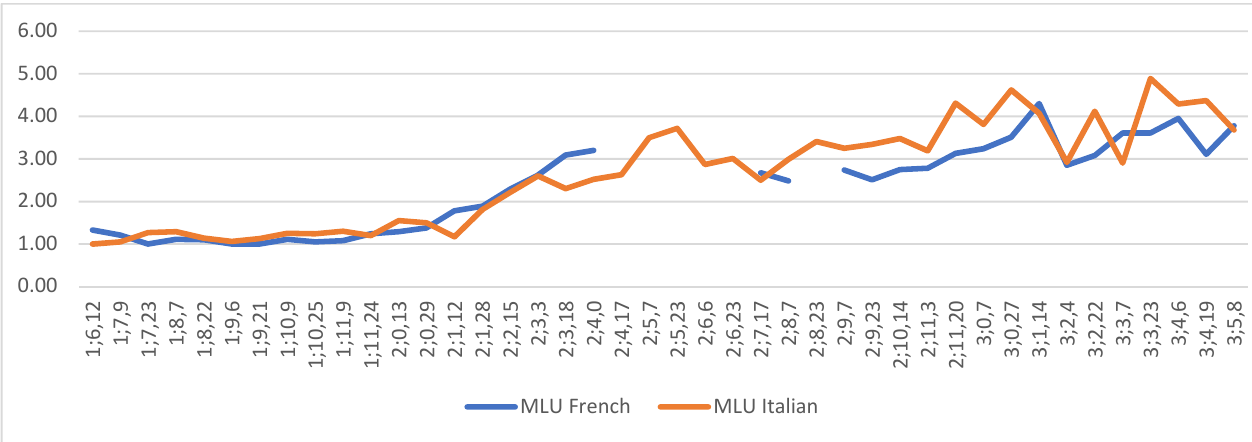
Figure 2. Si_fi’s MLU development in French and Italian.